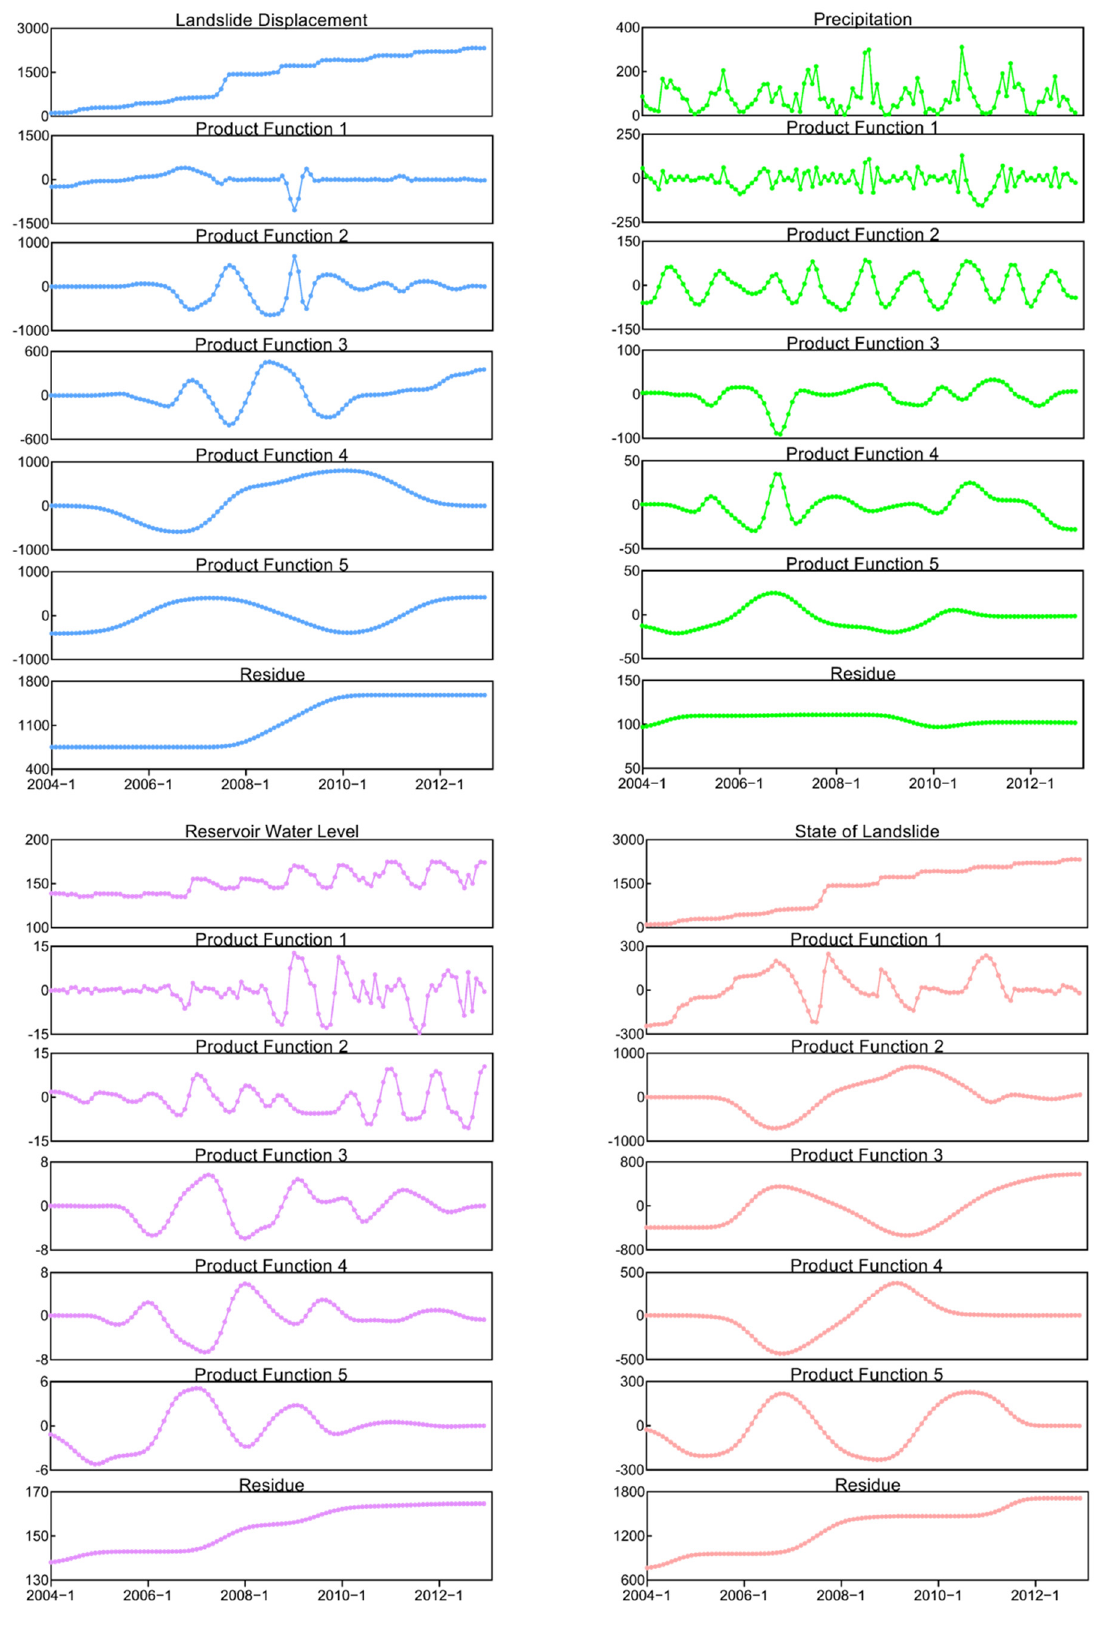
Figure 6. Subsequence decomposition of the landslide displacement, precipitation, reservoir water level, and landslide state.